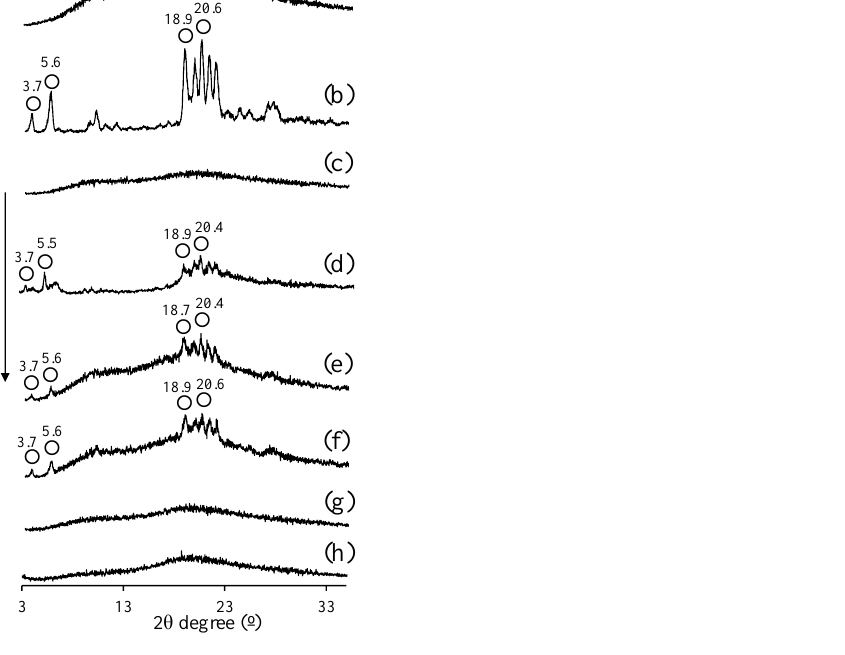
Figure 7. PXRD patterns of Sol/ASC-DP systems. ( a ) Sol, ( b ) ASC-DP, ( c ) EVP (Sol), ( d ) EVP (ASC-DP), ( e ) PM (Sol/ASC-DP = 9/1), ( f ) PM (Sol/ASC-DP = 8/2), ( g ) EVP (Sol/ASC-DP = 9/1), and ( h ) EVP (Sol/ASC-DP = 8/2). ○ : ASC-DP diffraction peaks.